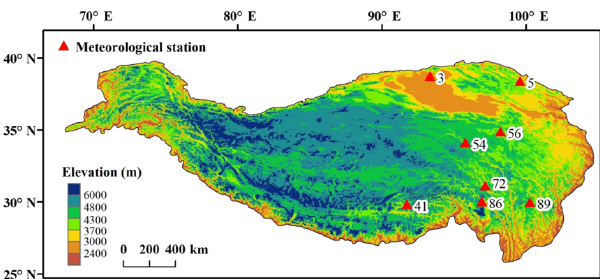
Figure 10. Locations of four representative CMA stations for T min (Nos. 54, 56, 72, 86) and T max (Nos. 3, 5, 41, 89)